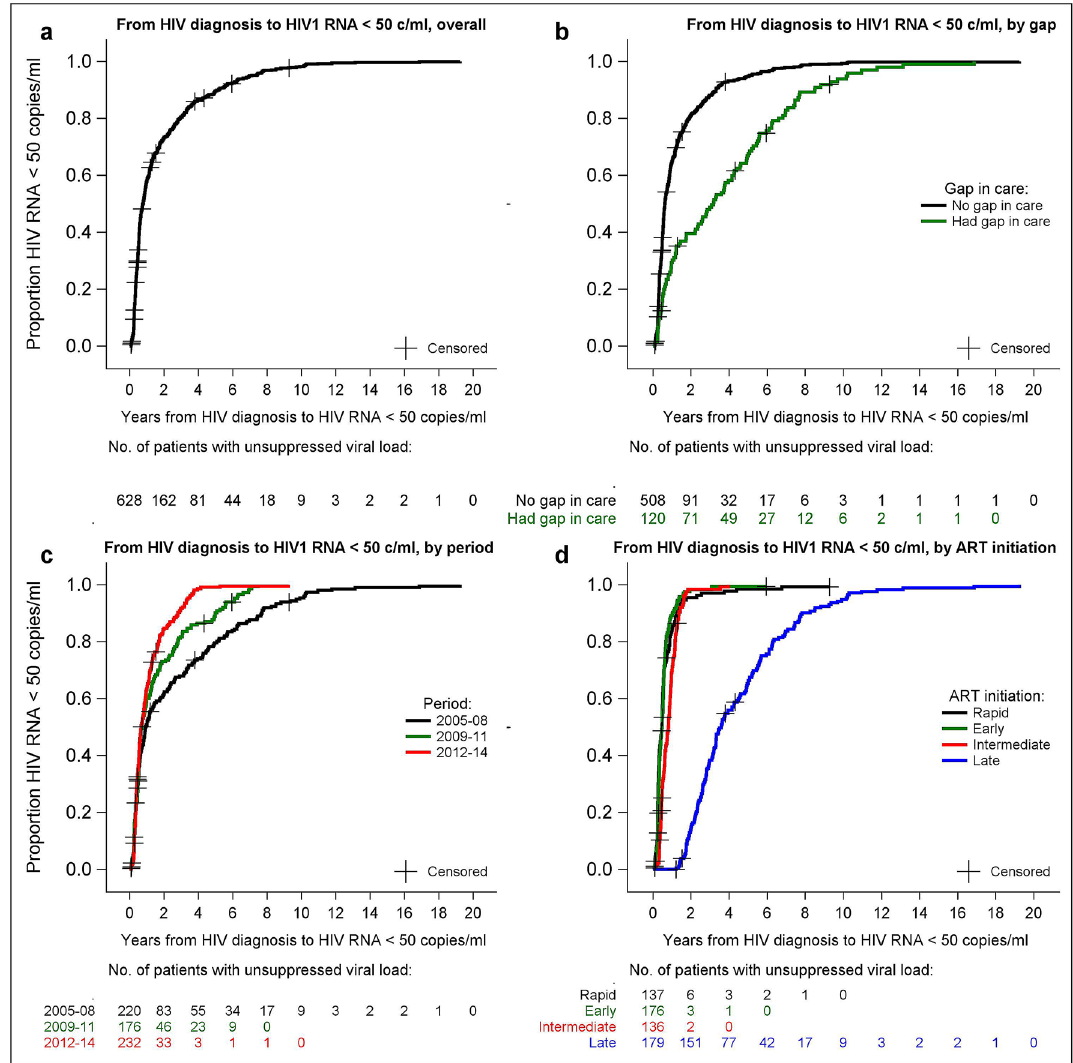
Figure 2. Kaplan–Meier plots of time from HIV diagnosis to undetectable plasma HIV-RNA: ( a ) overall; ( b ) according to gap in care; ( c ) by period of ART initiation; and ( d ) timeliness of ART initiation (rapid = within 7 days early = 8 to 30 days, intermediate = 31 days to one year, late > 1